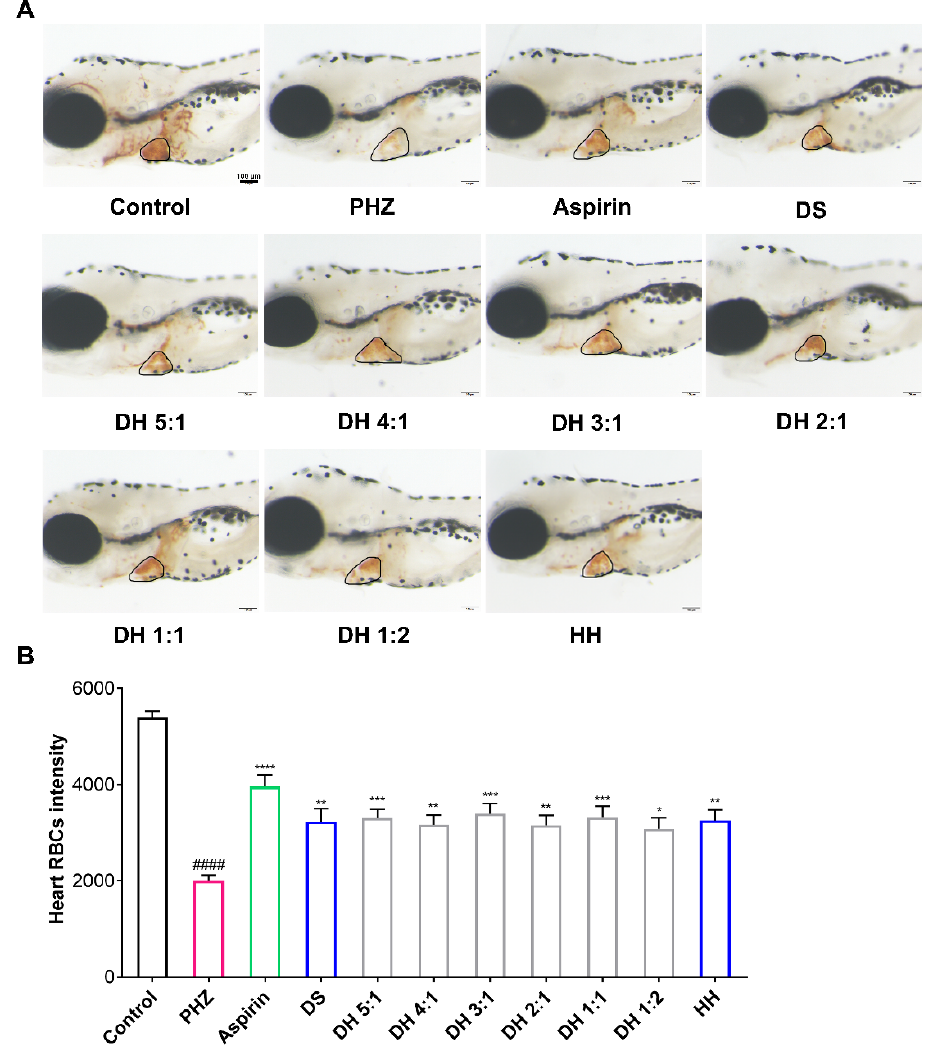
Figure 1. Danshen-Honghua (DH) herbal pair alleviated phenylhydrazine (PHZ)-induced throm- bosis in zebrafish. The zebrafish thrombosis was induced by PHZ (1.5 μ M) for 24 h, and the antithrombotic efficacy of different proportions of the DH herbal pair was evaluated with the heart red blood cell (RBC) intensity. ( A ) Staining of heart RBCs in different groups. ( B ) The heart RBC intensity (in the black circle) was quantitatively analyzed with Image Pro Plus 6.0 software. The data are presented as mean ± SEM (n = 10). DS: Danshen; HH: Honghua; DH: Danshen-Honghua. * p < 0.05, ** p < 0.01, *** p < 0.001, **** p < 0.0001 vs. PHZ group; #### p < 0.0001 vs. control group.